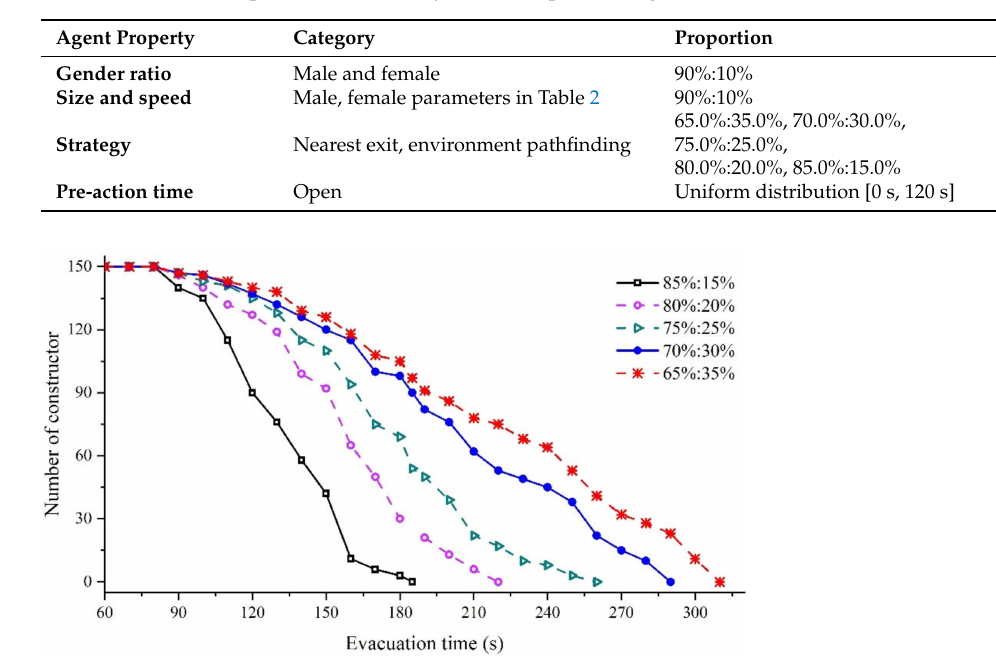
Table 6. Constructor parameters in analysis of occupational age’s influence.